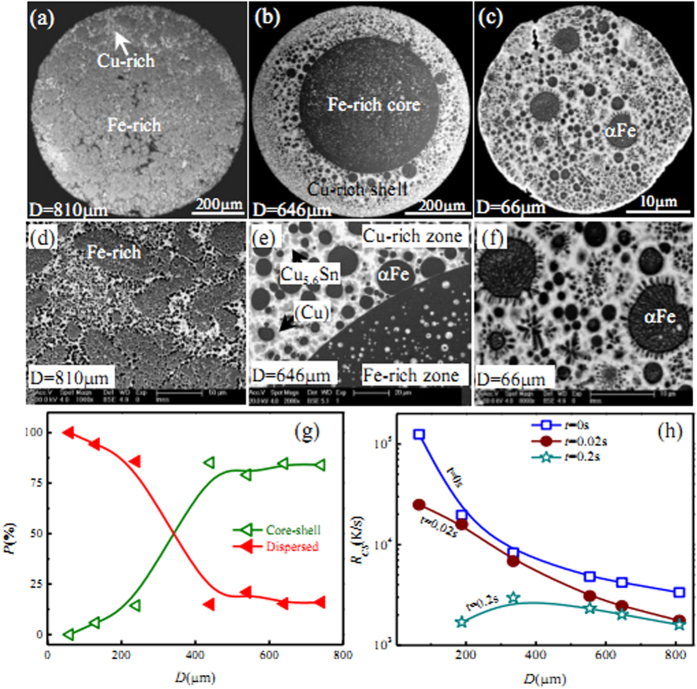
Structural morphologies induced by liquid phase separation of ternary Fe47.5Cu47.5Sn5 alloy versus droplet diameter.(a–c) macrostructures, (d–f) microstructures, (g) forming probability, and (h) cooling rate. The black is primary αFe phase, the grey is (Cu) phase, and the white is Cu5.6Sn phase respectively.